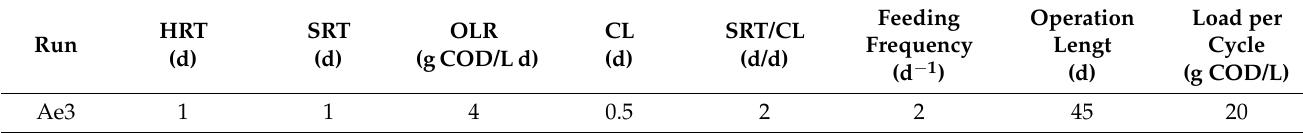
Table 4. Operating parameters applied to Ae3 SBR